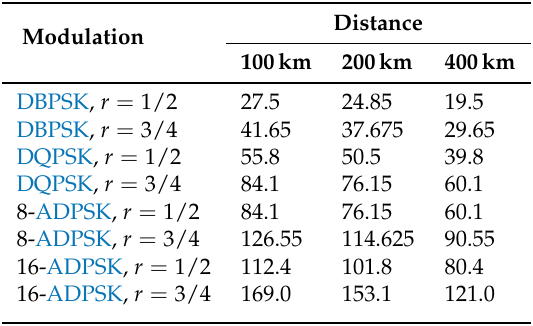
Table 6. Modulation types and data rates (in kbit/s) for TDD (from caller to responder).